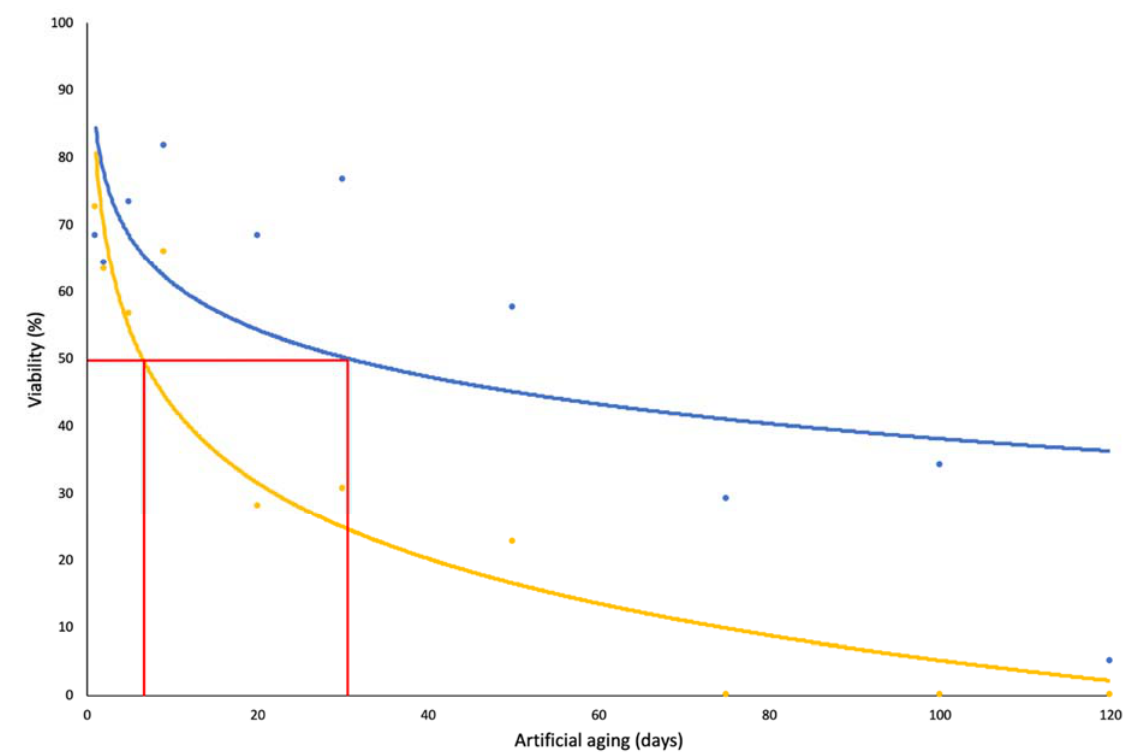
Figure 2. The effect of artificial ageing on viability (%) for N. trichotoma determined by germination (yellow) and tetrazolium (blue). Survival curve was fitted to each data set to represent the confidence limits of the probit analysis. The probit analysis determined P 50 = 5.8 days and P 50 = 31.3 days for the germination and tetrazolium trials, respectively, and these values are highlighted in red.